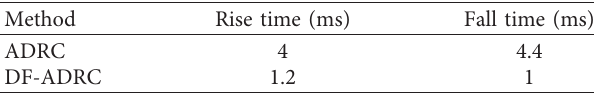
Figure 19: The comparison of results between ADRC and TD- ADRC under sinusoidal input (1A, 50 Hz). Table 3: Step input response of ADRC and